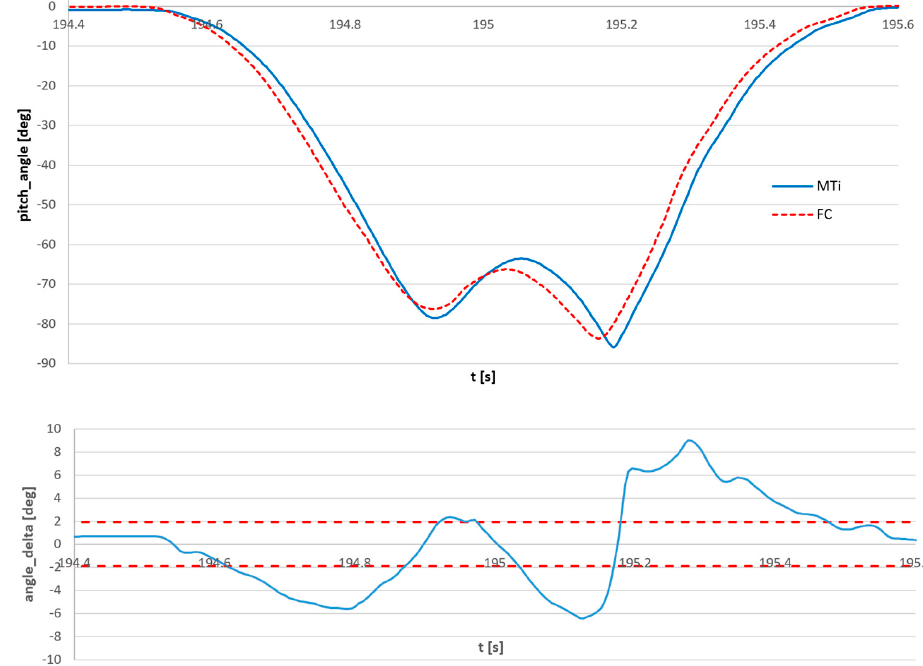
Figure 18. The magnified view at the time of maximum error from Figure 17, the signals measured by the reference sensor and the FC sensor ( top ) and error of estimation ( bottom ). The red dashed lines in the bottom view represent the standard deviation of the FC signal according to the reference MTi signal.